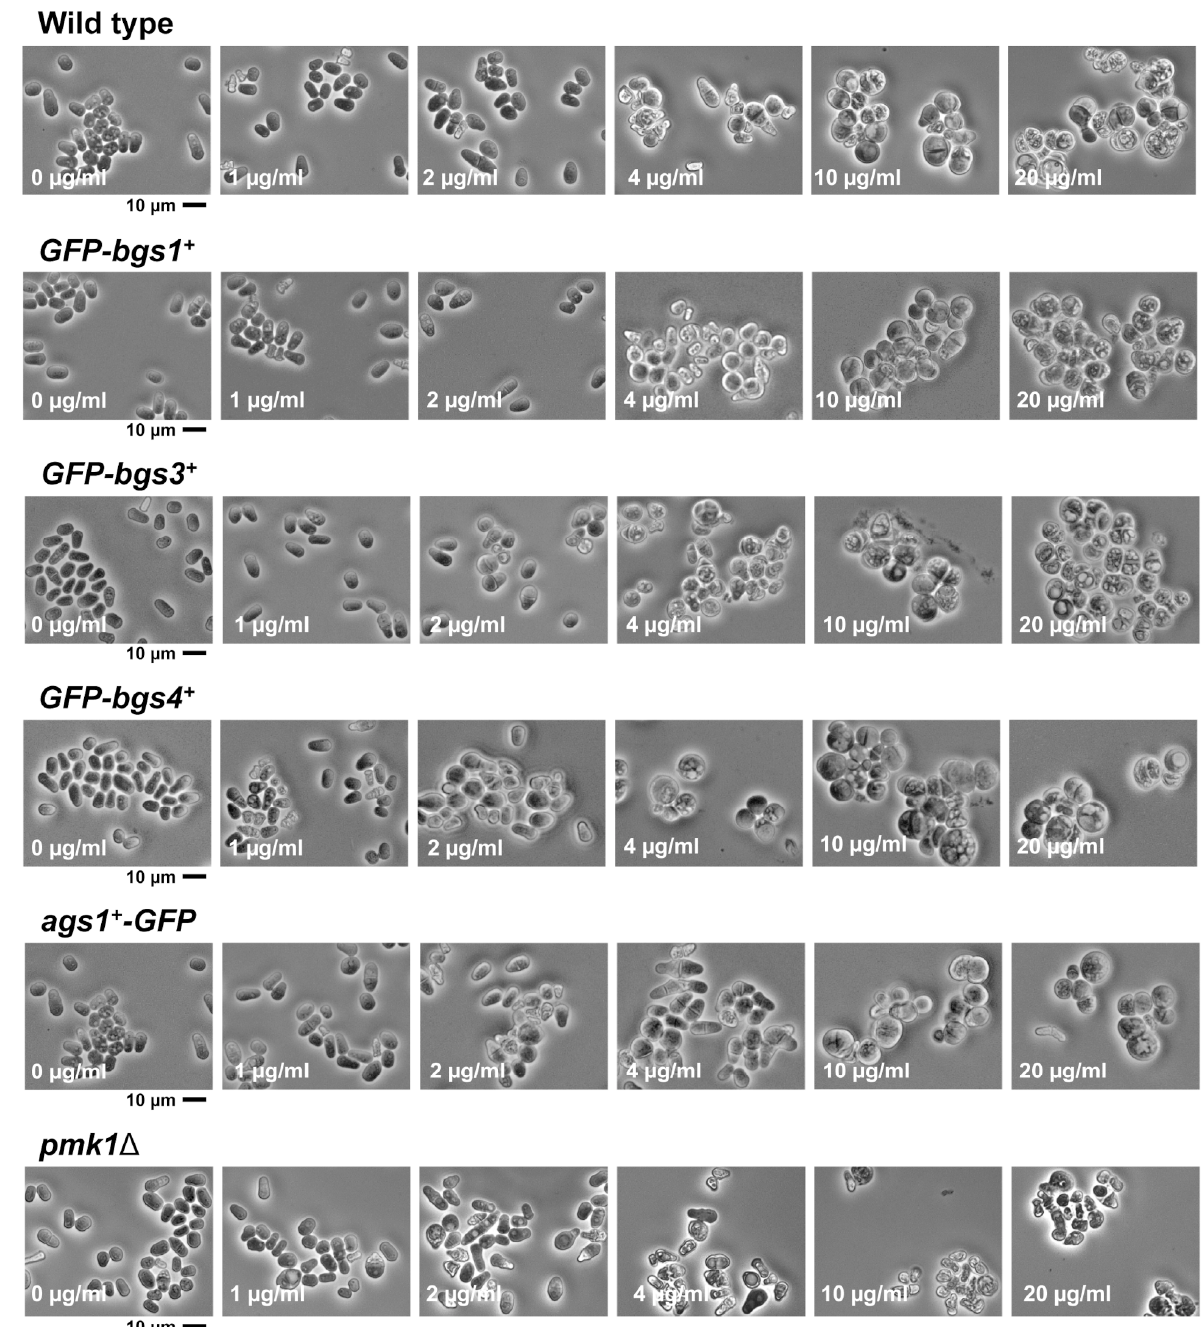
Figure 1. Morphology of WT, GFP-GSs and pmk1 ∆ cells after 24 h of growth in the presence of increasing doses of the echinocandin drug caspofungin. Early logarithmic phase cells of the indicated strains growing in YES (a specific culture medium for S. pombe ) liquid medium at 28 ◦ C were diluted to a high cell density of 3 × 10 6 in microcultures of YES liquid medium containing either DMSO (0.4%, control) or increasing doses (1, 2, 4, 10, and 20 µ g/mL) of the antifungal, grown with shaking for 24 h and imaged using phase ‐ contrast microscopy. Scale bars: 10 μ m.